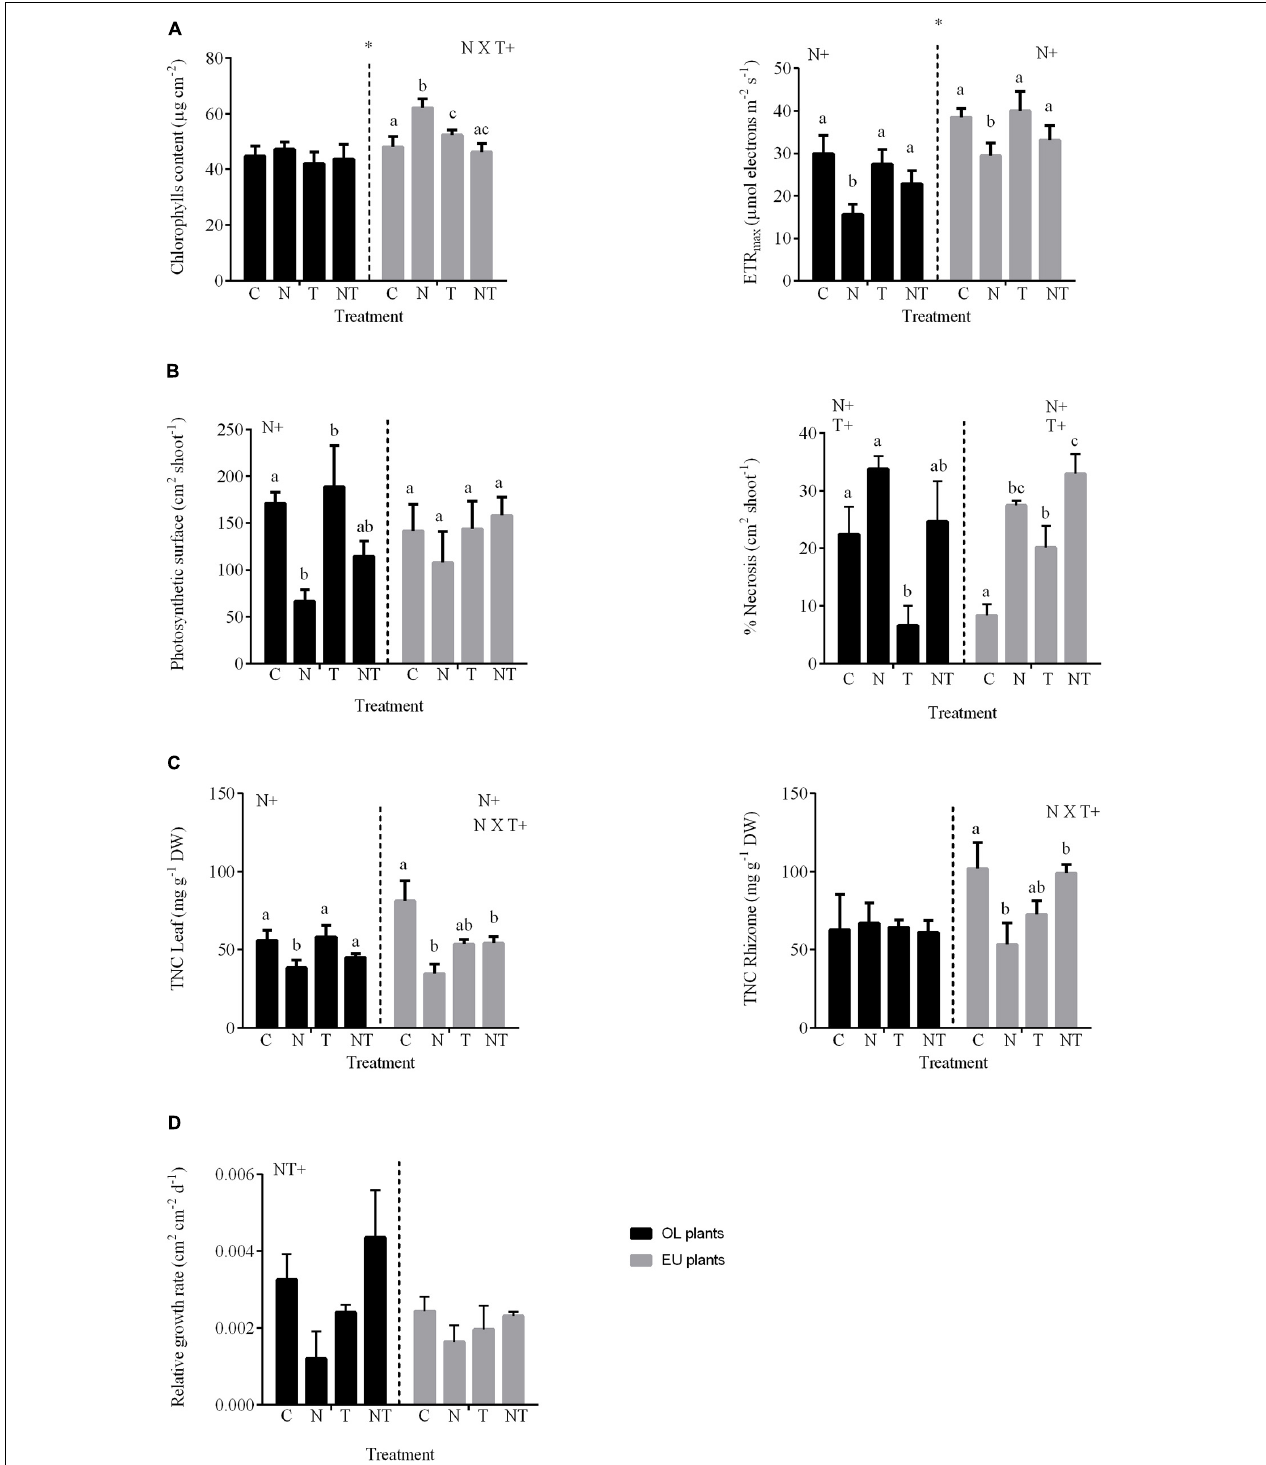
FIGURE 3 | Endpoints measured in OL (oligotrophic) and EU (eutrophic) plants after 5 weeks of the exposure to high temperature and nutrient enrichment. (A) Chlorophyll content and maximum electron transport rate (ETR m ); (B) Necrotic area and photosynthetic surface; (C) Total non-structural carbohydrates (TNC) measured in leaves and rhizomes; (D) Relative growth rate. Asterisks indicate differences between OL and EU plants (ANOVA 3-way); ( + ) indicates factors where significant differences were found between levels of factor after ANOVA 2-way and post hoc test. Different lowercase letters indicate the groups of homogeneous means obtained in the post hoc ( P <